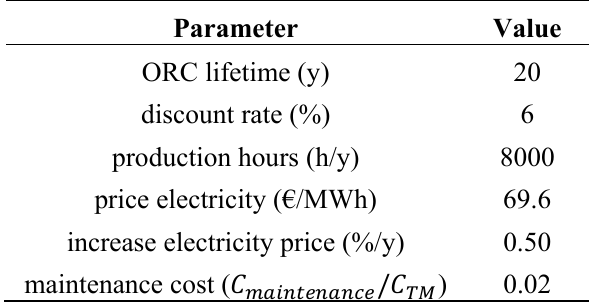
Table 11. Assumptions for net present value (NPV) calculation.